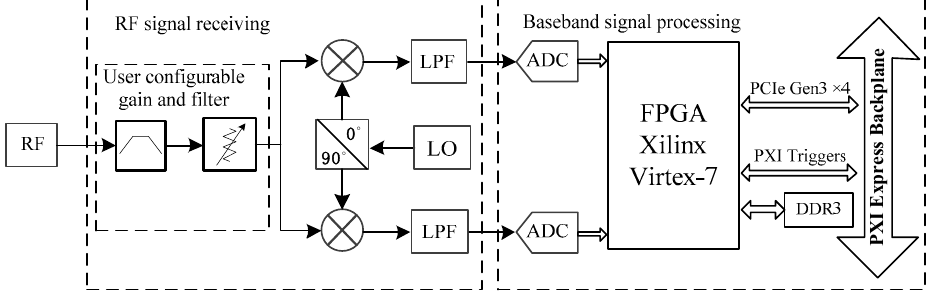
Figure 6. Block diagram of the experimental platform.